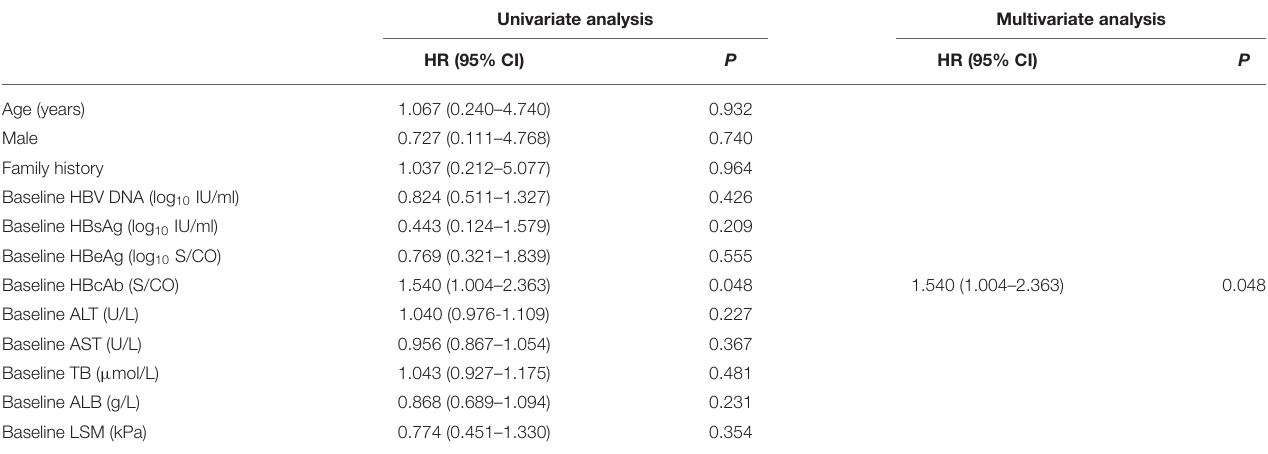
TABLE 4 | Factors predictive of HBeAg seroconversion in liver biopsy-proven IT and MA-phase patients. Univariate analysis Multivariate analysis